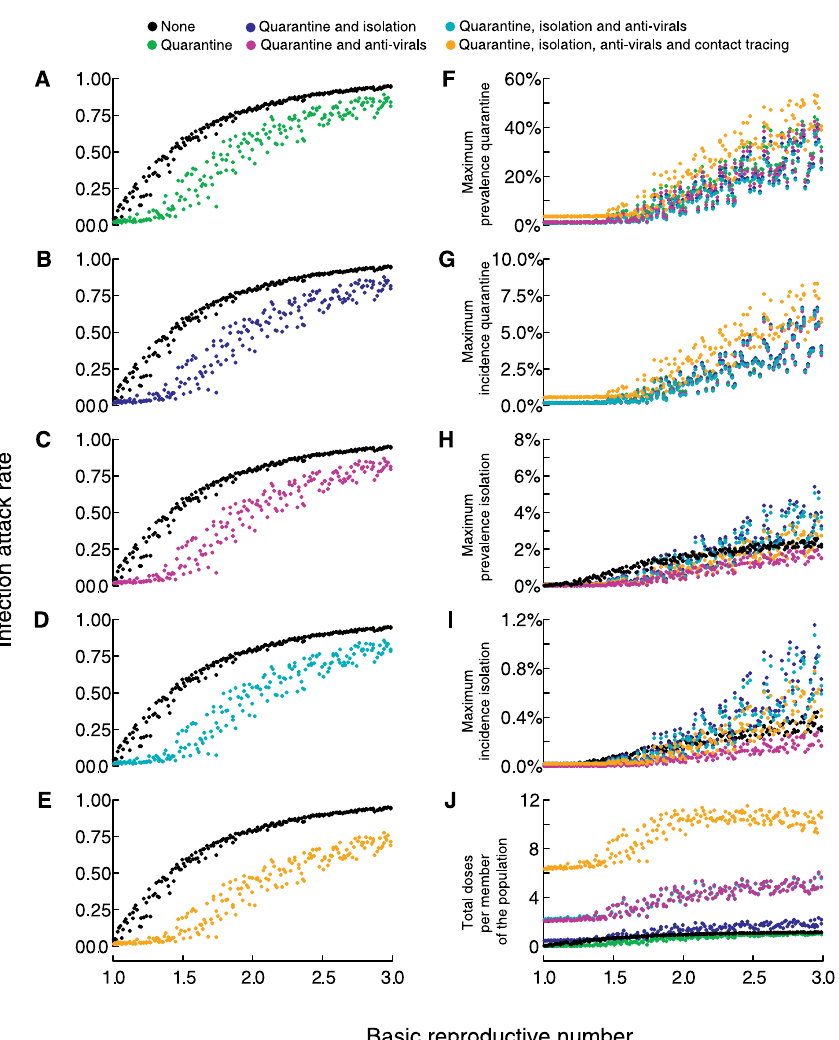
Figure 3. Multivariate Sensitivity Analyses (A–E) The efficacy of different household-based intervention policies (same color key as in Figure 2) compared to taking no action for 200 random samples, selected using a Latin hypercube [17], across a multivariate range of transmission parameters (see Table 1). The y -axes show the expected